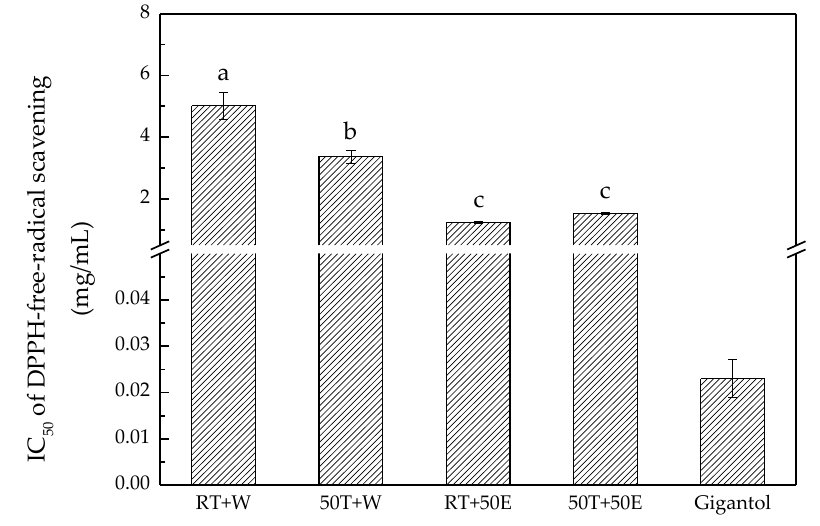
Figure 4. DPPH free-radical scavenging for the four extracts and gigantol. Treatment means with the same letter are not significantly different.